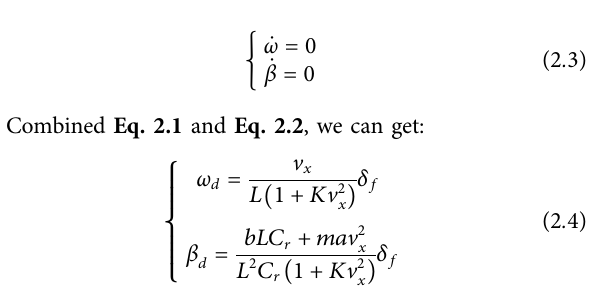
FIGURE 5 | Topology diagram of direct yaw moment control